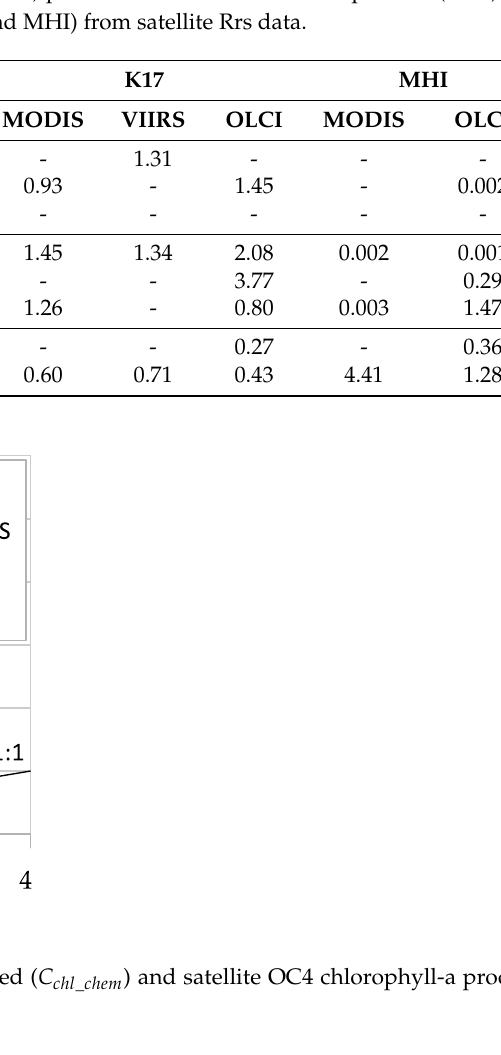
Figure 9. The comparison between the measured ( 𝐶 𝑐ℎ𝑙_𝑐ℎ𝑒𝑚 ) chlorophyll-a concentration and results of K17 and MHI algorithms. 4. Discussion The obtained in situ reflectance spectra represent different hydro-optical conditions, from blue oceanic water to brown river runoff. At the same time, the discrepancies be- tween remote sensed and in situ reflectance change with wavelength in a similar way, as shown in Figure 6; although a certain part of this discrepancy can be attributed to a natural temporal variability of seawater properties, since the time difference is relatively large. In the Kara Sea, the terrigenous CDOM, supplied by Ob and Yenisei rivers, represents the main CDOM source. In the Arctic Ocean, the contribution of CDOM absorption at 443 nm to the total non-water absorption can reach ~50%. It was shown that systematic differences in chlorophyll retrievals resulting from different ocean color models are related to each model’s ability to account for the absorption of light by CDOM [18]. Accordingly, the var- iability of CDOM absorption in the surface layer is associated with the speed of river